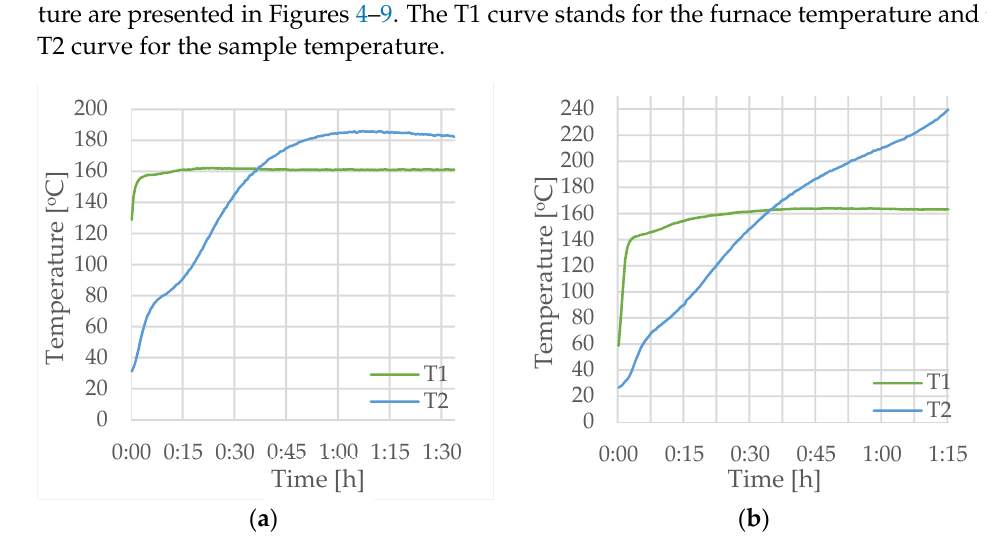
Table 8. The spontaneous ignition behavior analysis results.